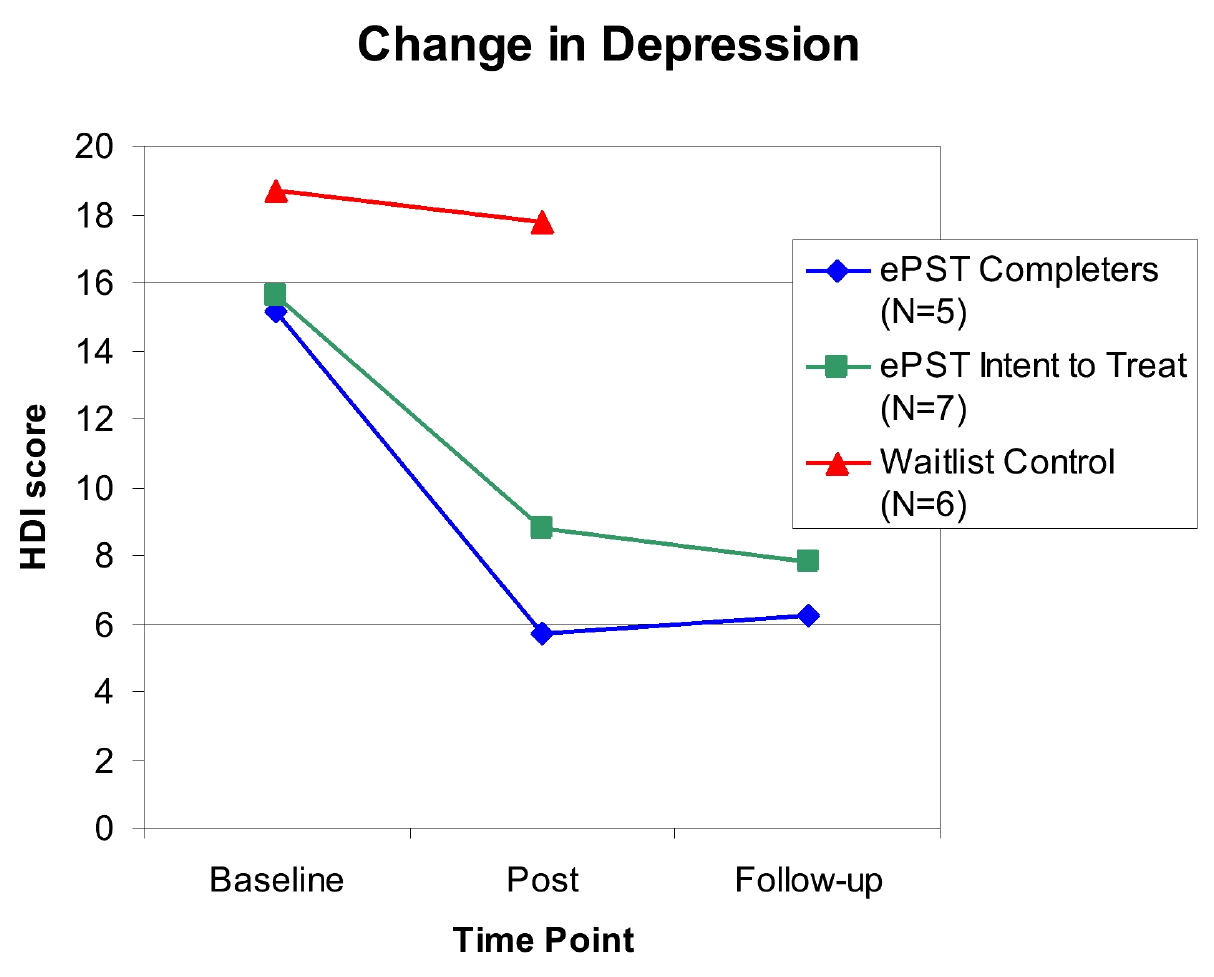
Figure 3. Change in